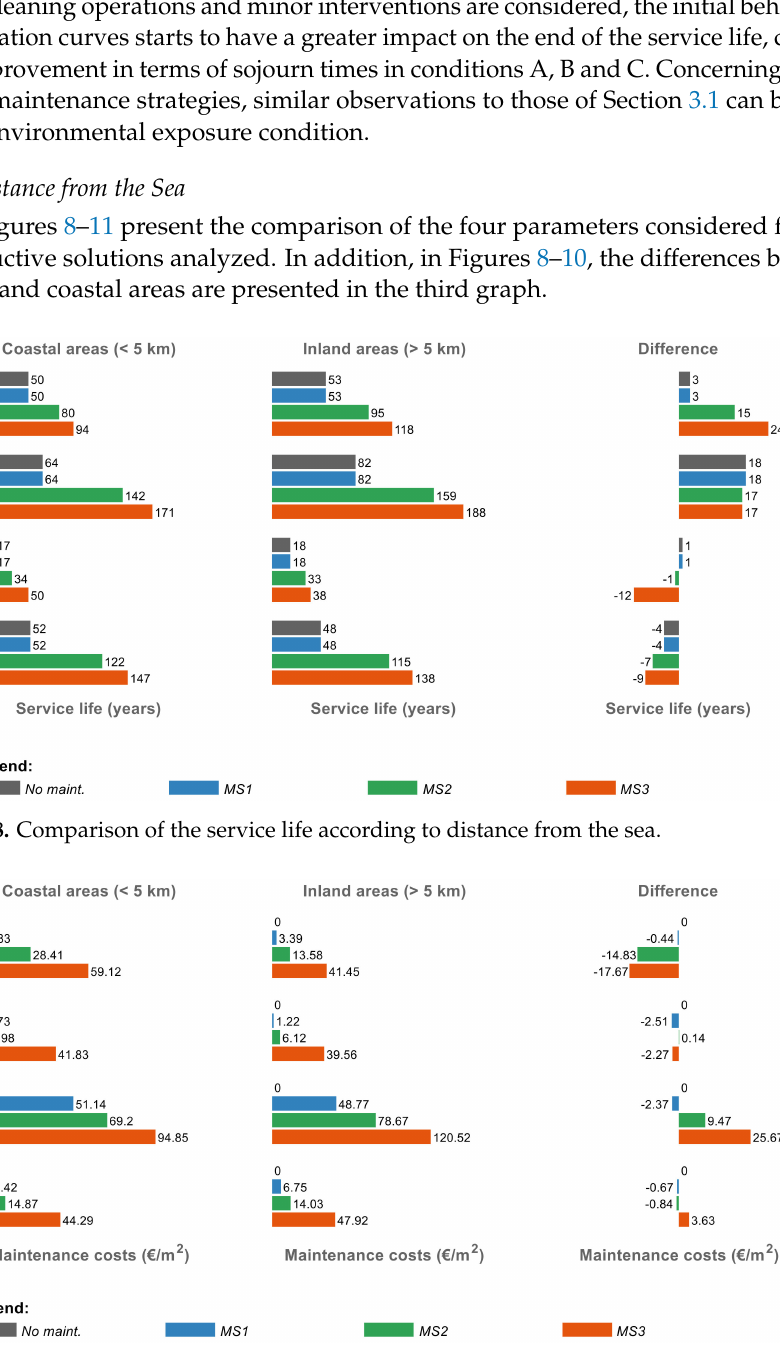
Figure 9. Comparison of the maintenance costs according to distance from the sea for a time horizon of 80